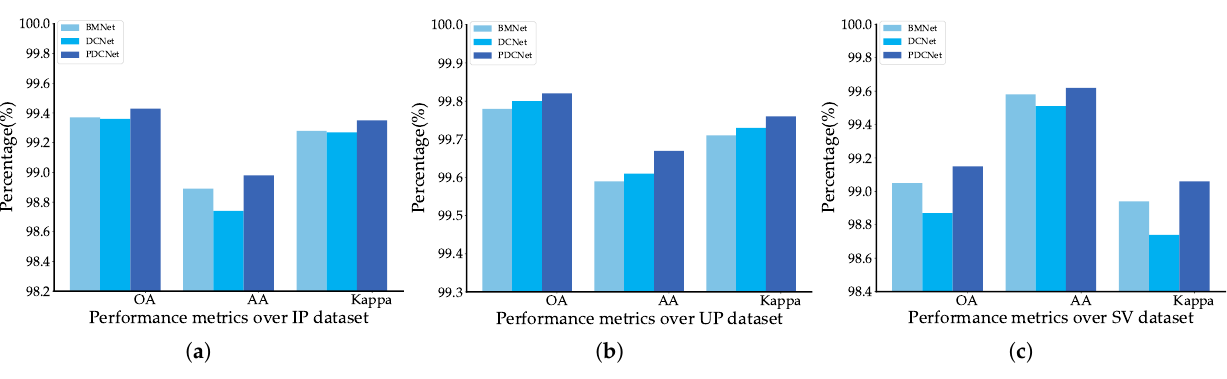
Figure 10. Performance of BMNet, DCNet and PDCNet on different HSI datasets. ( a ) Metrics on IP dataset. ( b ) Metrics on UP dataset. ( c ) Metrics on SV